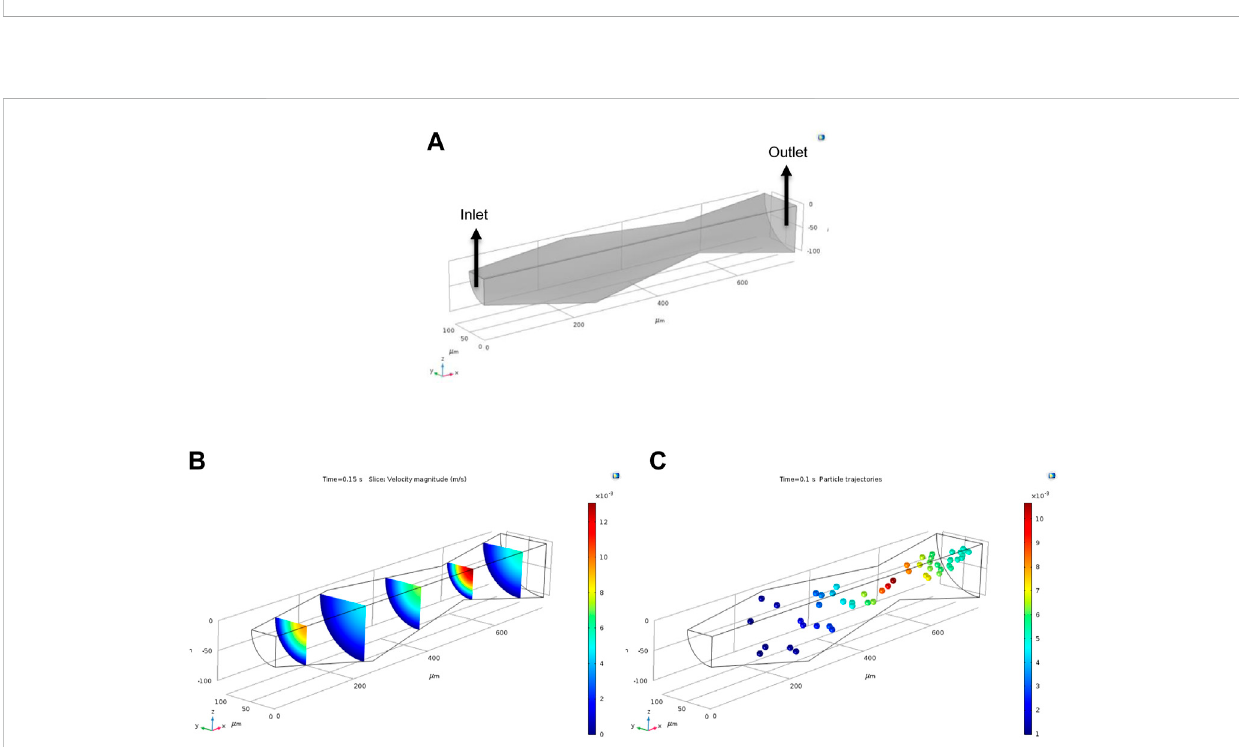
FIGURE 5 (A) Basicschematicoftheconverging – divergingtubegeneratedusingCOMSOL. (B) Fluidvelocitydistributionand (C) particletrajectoriesinsidethe converging – diverging tube. Color scale represents the magnitude of fl uid and particle